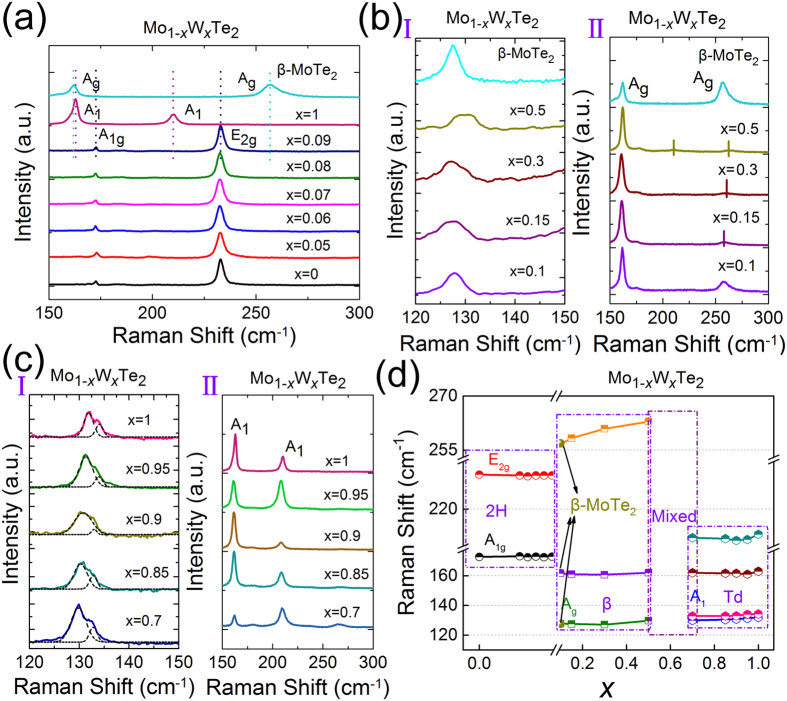
(a) Raman spectra (150~300 cm−1) of Mo1−xWxTe2 single crystals with composition x in the range of 0~0.09. (b) Raman spectra (I: 120~150 cm−1; II: 150~300 cm−1) of β-MoTe2 and Mo1−xWxTe2 single crystals with x composition in the range of 0.1~0.5. (c) Raman spectra (I: 120~150 cm−1; II: 150~300 cm−1) of Mo1−xWxTe2 single crystals with x composition in the range of 0.7~1.0. (d) Composition-dependent Raman frequencies of β-MoTe2 and Mo1−xWxTe2 single crystals (x = 0~1.0). All the Raman spectra were measured at room temperature.